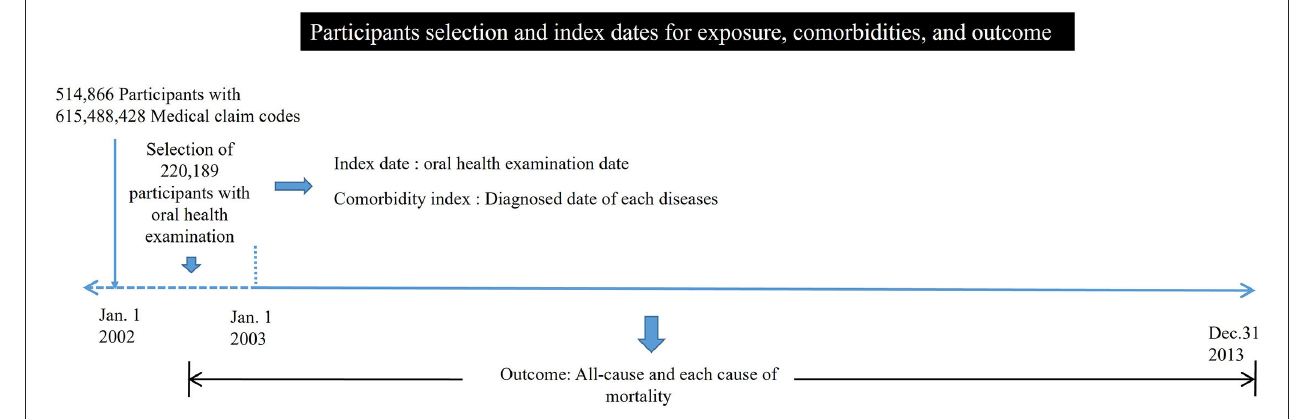
FIGURE 1 | The participant selection and index date of exposure in the current